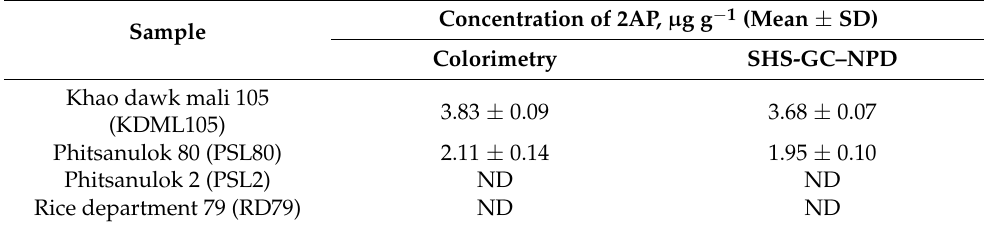
Table 2. Quantitative analysis of 2AP in fragrant and nonfragrant rice